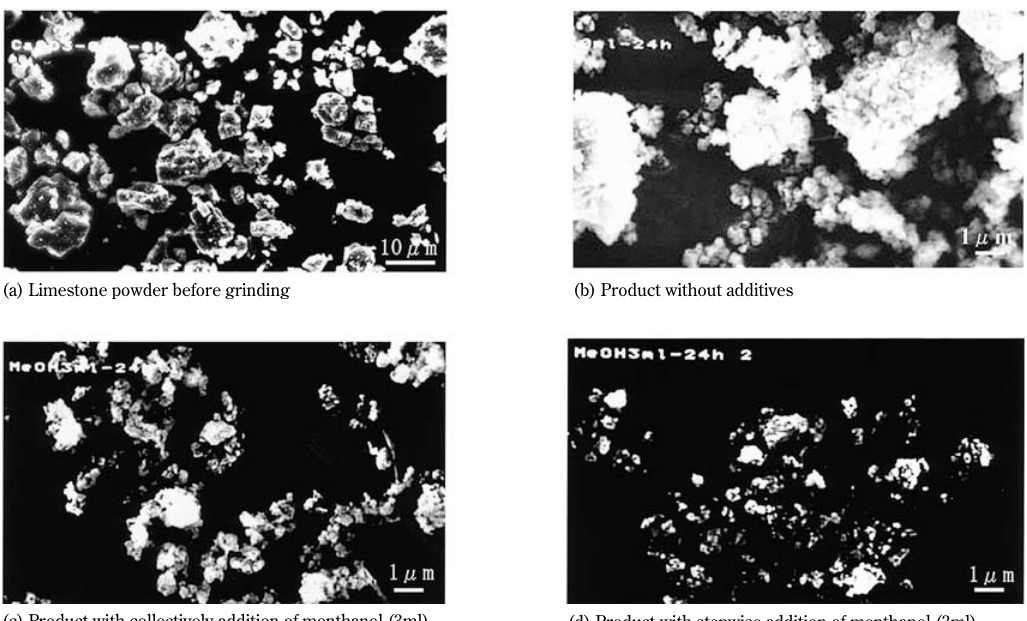
Fig. 7 Electron scanning micrographs of limestone before and after grinding for 24 hours, (a) before grinding (b) after grinding without additives (c) with collective addition of methanl (d) with stepwise addition of